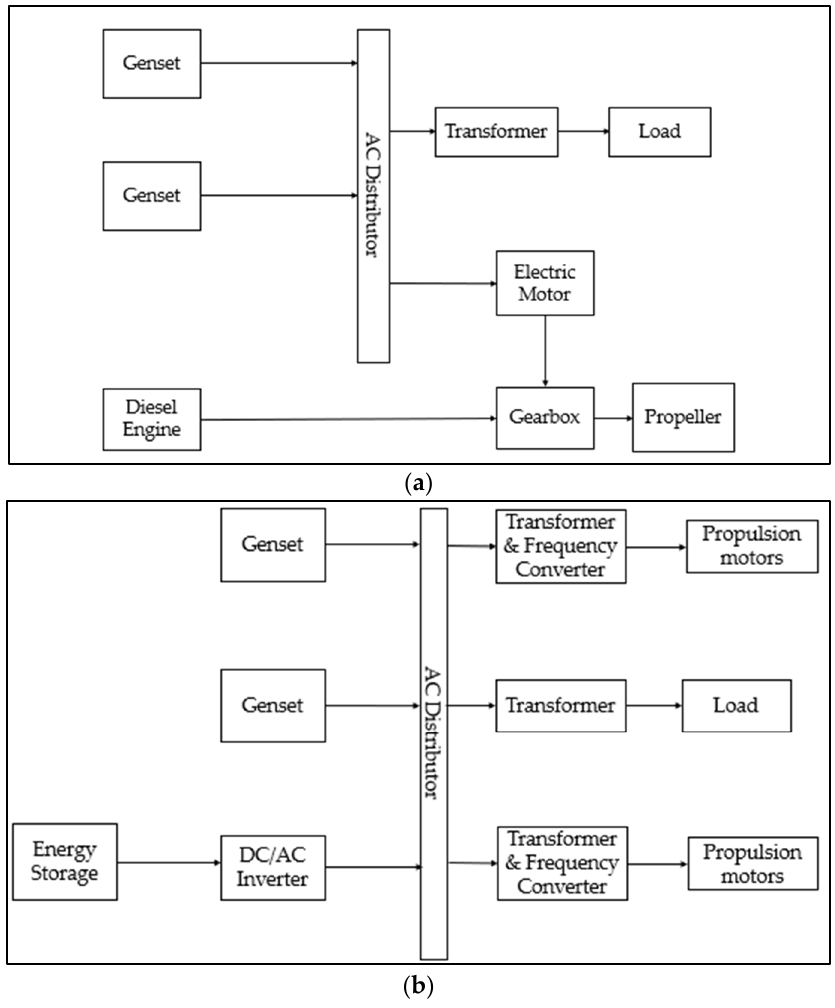
Figure 4. ( a ) Hybrid diesel with Gensets propulsion system; ( b ) Hybrid diesel with battery propul- sion system.